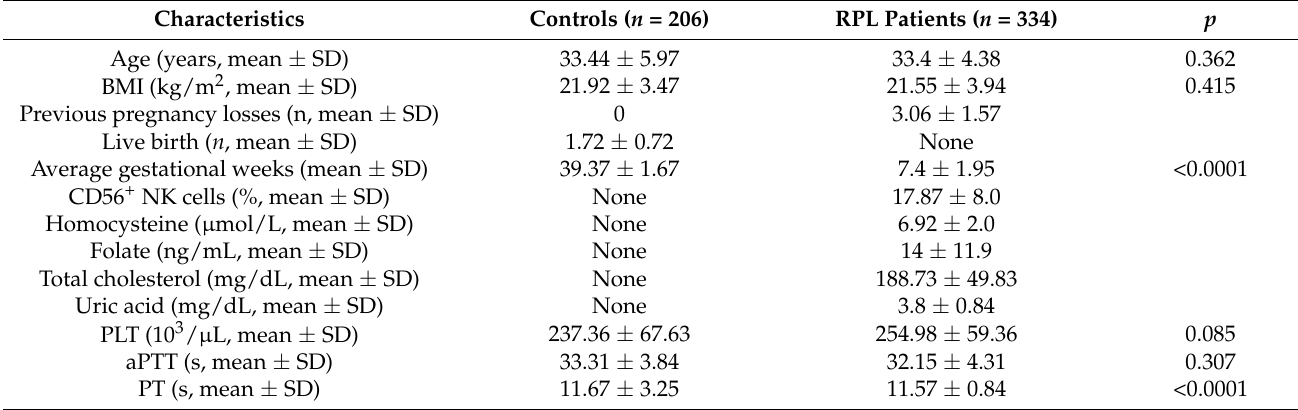
Table 1. Clinical profiles between RPL patients and control